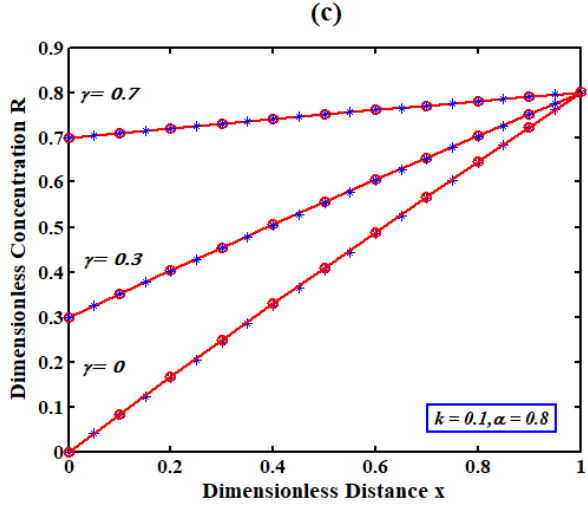
Figure 2. ( a – c ) Profile of the normalized steady-state concentrations R versus the normalized distance x for various values of the parameters k , α , and γ using Equations (10) and (15) The solid line denotes the AGM method, (o o o) represents DTM, and (* * *) denotes numerical simulation.